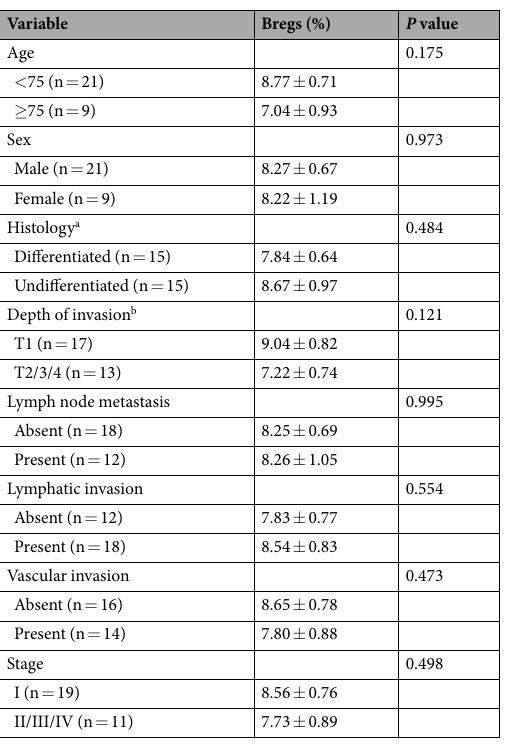
Table 1. Frequency of peripheral Bregs and clinicopathological variables in gastric cancer patients. a Differentiated, papillary, or tubular adenocarcinoma; undifferentiated, poorly differentiated, or mucinous adenocarcinoma, or signet-ring cell carcinoma. b Depth of invasion: T1, tumor invasion of the lamina propria or submucosa; T2, tumor invasion of the muscularis propria; T3, tumor invasion of the subserosa; T4, tumor penetration of the serosa or tumor invasion of adjacent organs. All results are expressed as the mean ± SD.